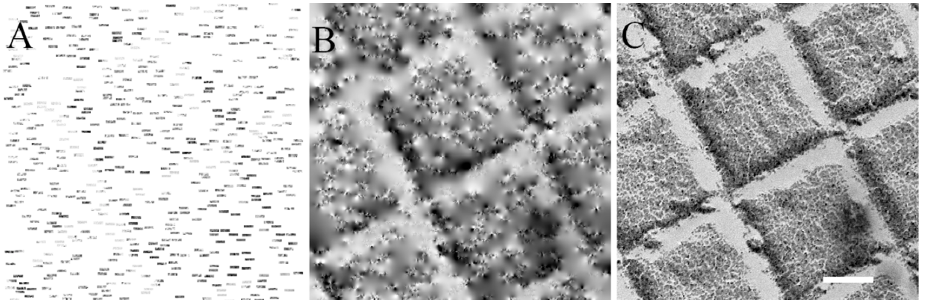
Figure 1. Collection of a sparse scanning transmission electron microscopy (STEM) image, inpainting reconstruction and comparison with ground truth. ( A ) Sparse STEM image downsampled to 12.5% using 512 blocks of 16 × 4 pixels. The white background corresponds to uncollected pixels. ( B ) Sparse image A after inpainting reconstruction. ( C ) Ground truth fully-collected STEM image of the very same ROI on the grid. Scale bar is 200 nm. The three subfigures have the same